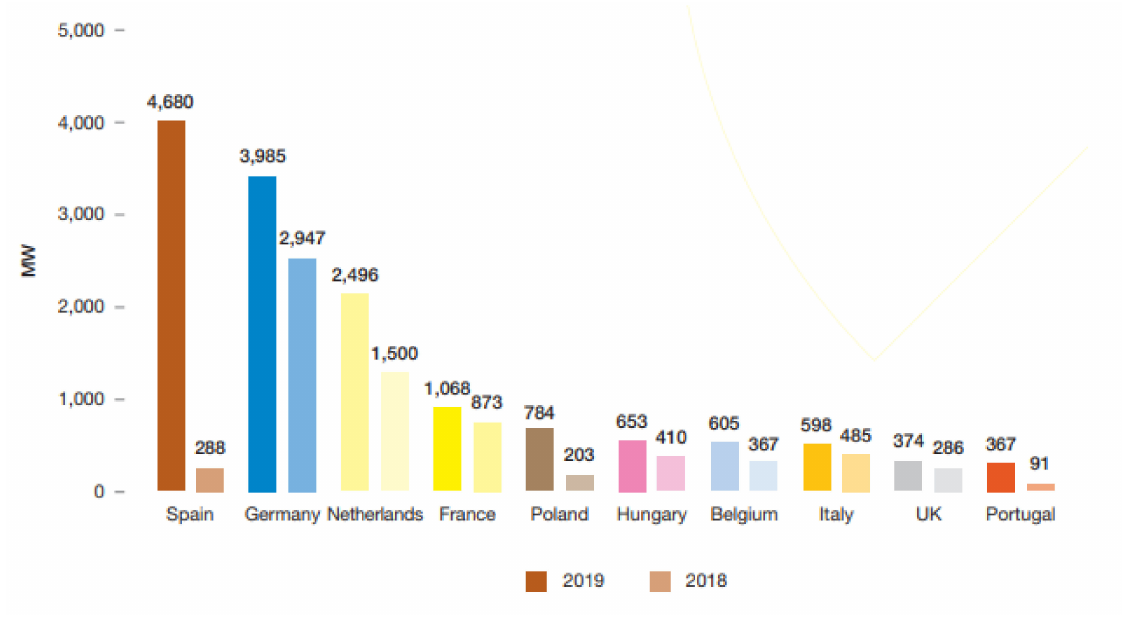
Figure 4. Top EU countries along with the UK Solar PV markets, 2018-19 [22]. The solar PV market has the potential and necessary support again to penetrate the energy market. Meanwhile, the solar thermal market shrunk by 6% in 2019 compared to 2018 while experiencing significant market pressure from PV and heat pumps for small- scale solar water heating systems. Since heating accounts for a significant amount of energy demand, the potential of hybrid photovoltaic/thermal (PVT) systems in combined power, heating and cooling should be utilised to escalate the share of renewables in district heating and cooling. PVT is attractive for applications with limited space [25] since it produces thermal and electrical energy [26] at a reduced cost compared to a separate PV and thermal collector system [27]. PVTs can be considered for several applications